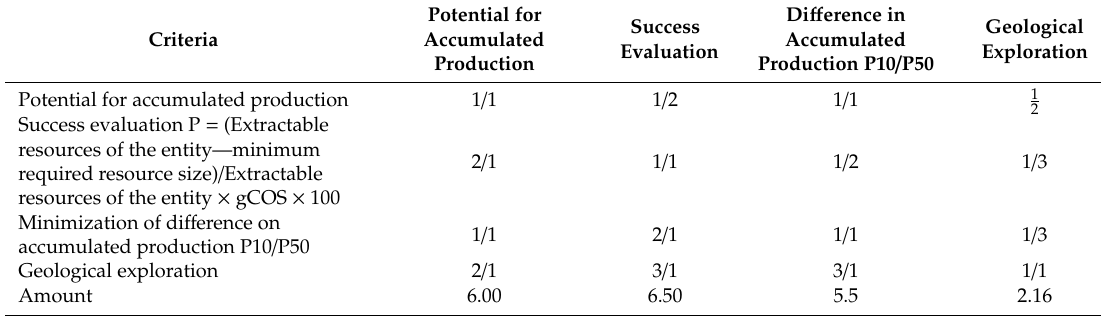
Table A4. Results of the assessment of the relative importance of the geological sustainability criteria.